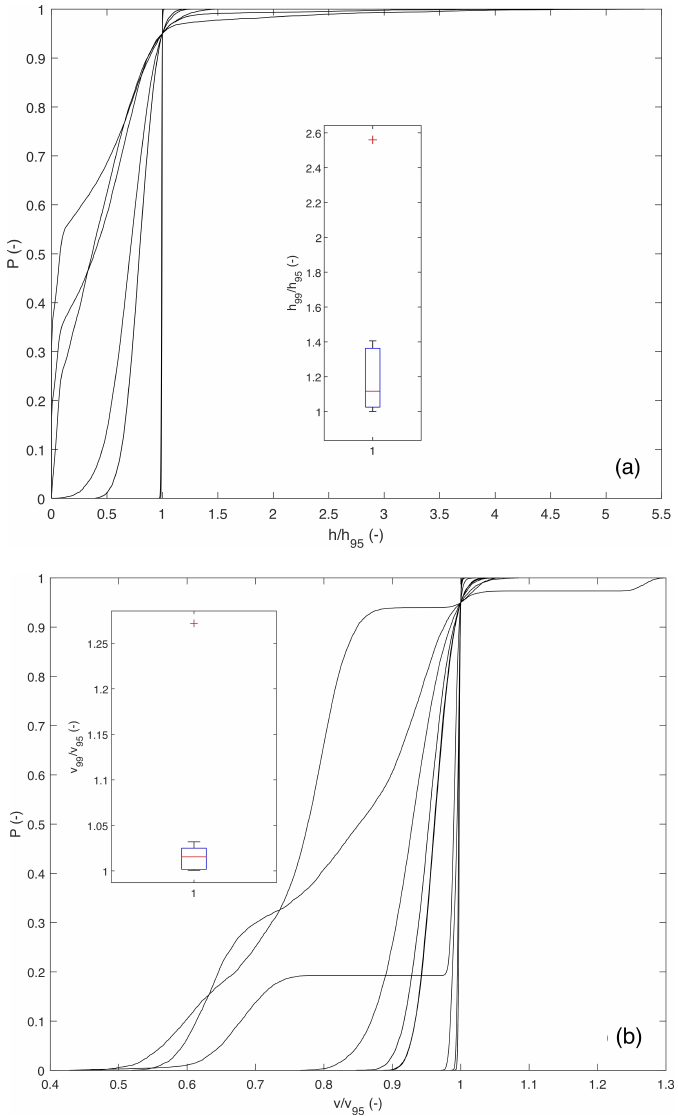
Figure 5. ( a ) Cumulative probability distribution function of h / h 95 and the boxplot of h 99 / h 95 , ( b ) Cumulative probability distribution function of v / v 95 and the boxplot of v 99 / v 95